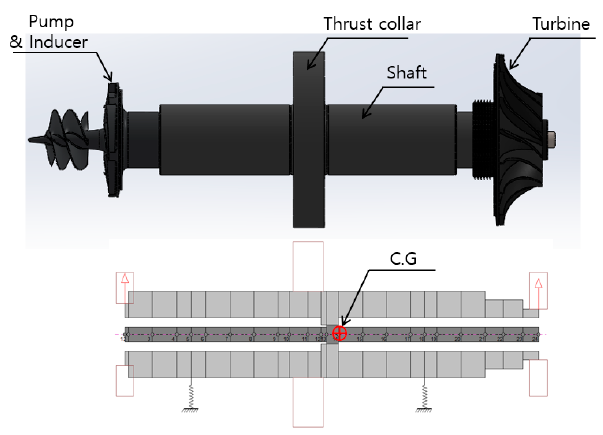
Figure 3. Rotordynamic analysis model for pump-drive turbine. (C.G.: center of gravity)